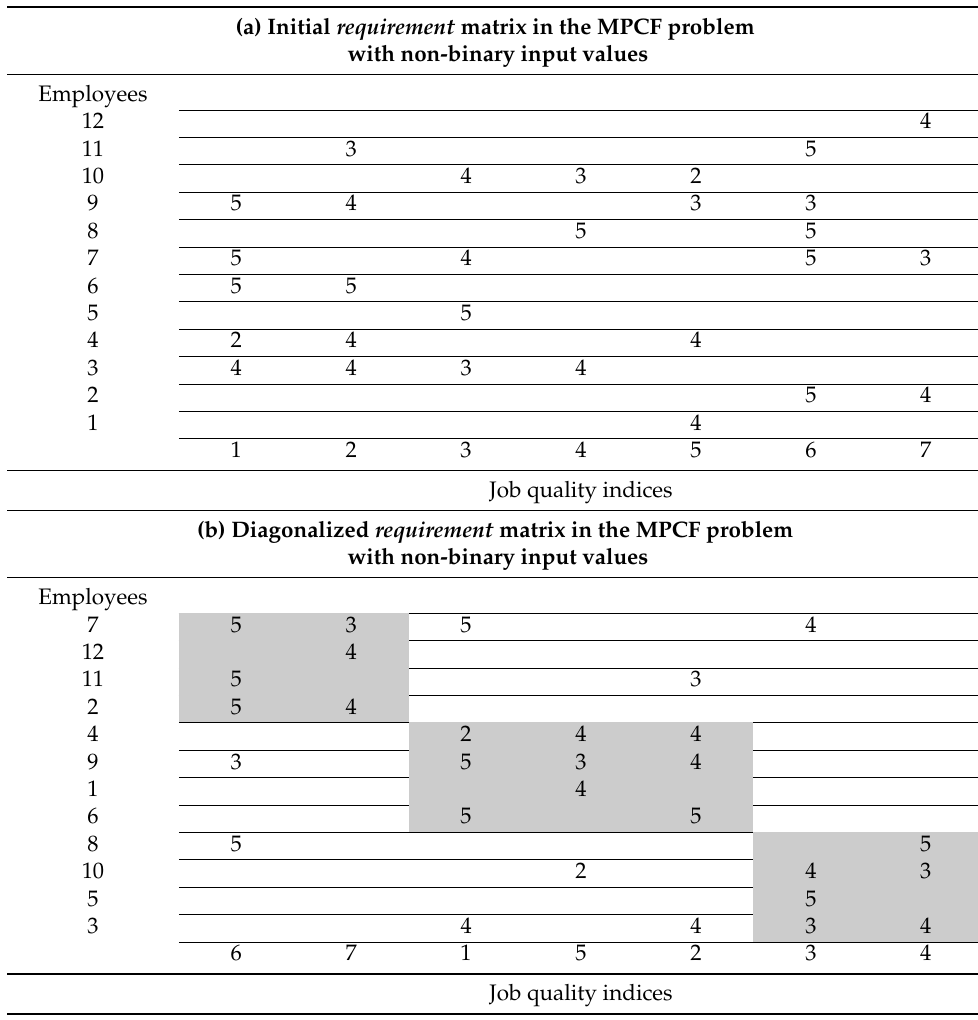
Table 2. Example of matrix rearrangement in the MPCF problem with non-binary input